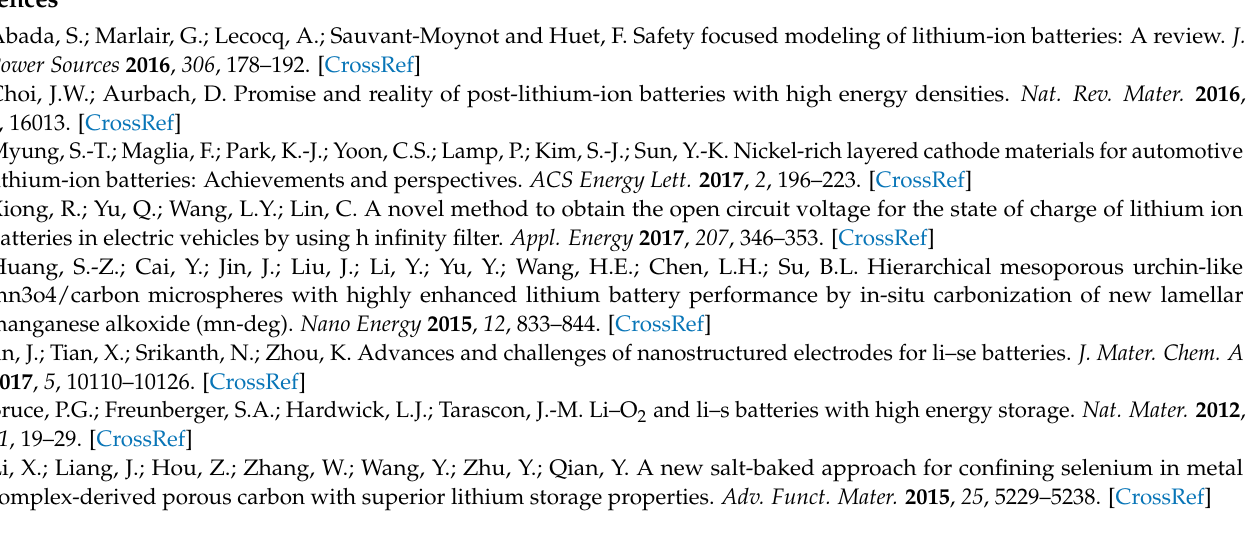
COF; Figure S5: The CV curve of Li-SeS 2 batteries with different separator at a sweep speed of 0.1 mV s − 1 ,0.2 mV s − 1 ,0.3 mV s − 1 and 0.4 mV s − 1 : (a) ATG-DMTZ-COF/PP separator. (b) blank PP separator. (c) Super P/PP separator. (d) The lithium ion diffusion coefficients of the three types of separator at different peak positions; Figure S6: The I p - v 0.5 curve of different separator at peaks A, B, C and D. Figure S7: The galvanostatic charge-discharge curve of (a) blank PP separator, (b) Super P/PP separator at a current density of 0.5 C; Figure S8: CV curve of (a) blank PP separator, (b) Super P/PP separator at a sweep speed of 0.1mV s − 1 ; Table S1 The performance of Li-SeS 2 batteries comparison chart of different